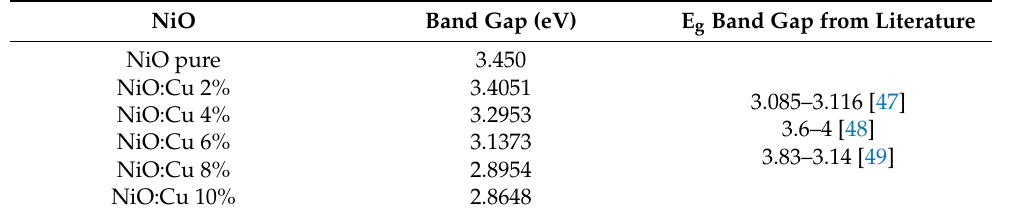
Figure 5. Plot of  h  2 vs. h  for Eg gap estimation. Figure 5. Plot of ( α h ν ) 2 vs. h ν for E g gap estimation. The obtained band gap values are presented in Table 4. The obtained band gap values are presented in Table 4. Table 4. Different values of band gap Table 4. Different values of band gap energy.